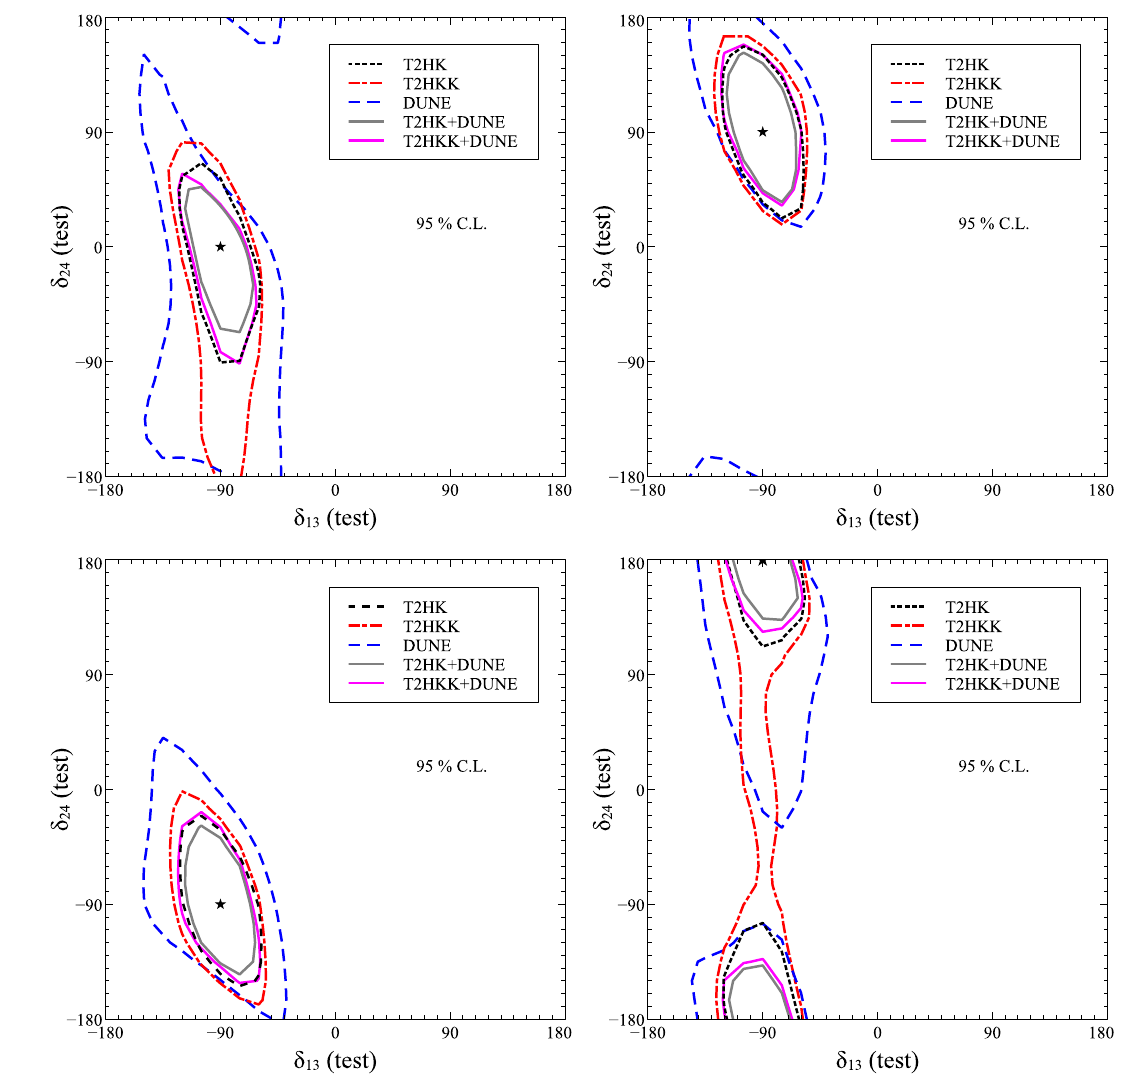
= − 90 ◦ ( δ = 180 ◦ ). The black dotted curve is for T2HK, the red δ 24 24 dash-dotted curve is for T2HKK, the blue dashed curve is for DUNE, the grey solid curve is for DUNE+T2HK and the magenta solid curve is for